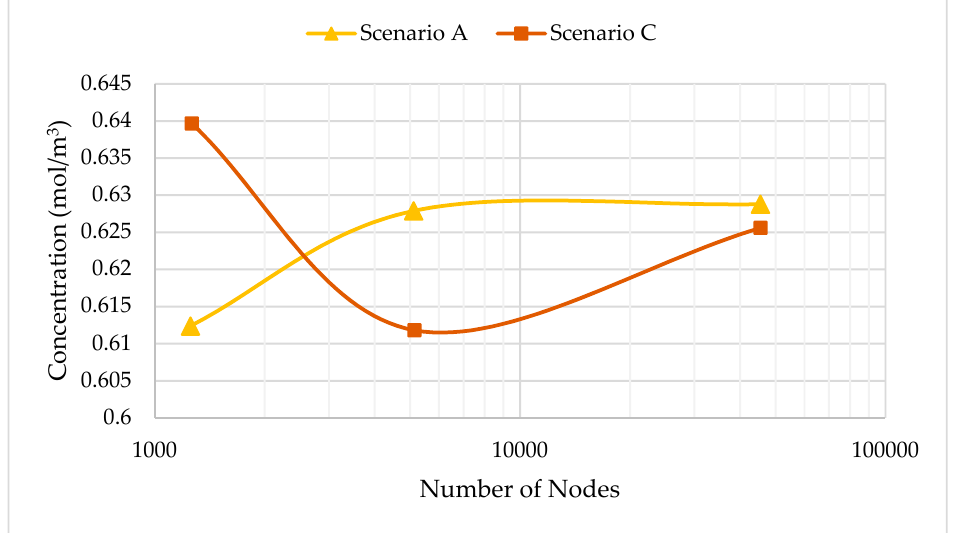
Figure 6. Variation of the time average concentration at a local point (x = 300 m; y = 0 m) versus the number of nodes used in the simulations (scenarios A and C).